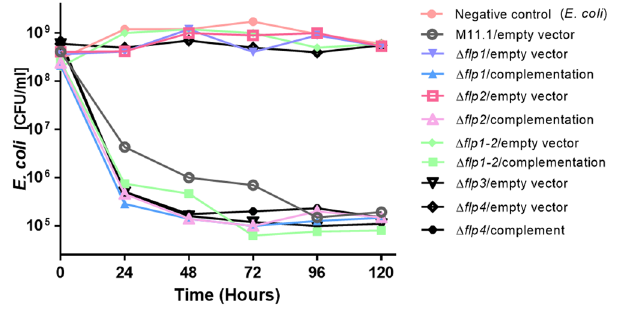
Figure 5. Effects of flp pilin gene deletion on predation. Both TAD-associated flp1, flp2 , and non-associated flp4 gene knockouts ( Δ flp1 , Δ flp2 , and Δ flp4 , respectively) are unable to prey, while Δ flp3 had no effect on predation. All strains regained the predatory phenotype of the parental strain (M11.1) upon complementation (comp. Δ flp1 , comp. Δ flp2 and comp. Δ flp4 ). In order to prevent polar effects, all knockouts were constructed as in-frame deletions, with only small non-functional peptides encoded in the remaining sequence (9–12 amino acids long). Complementation for each mutation was carried out using pPROBE-NT. Control strains carried an empty